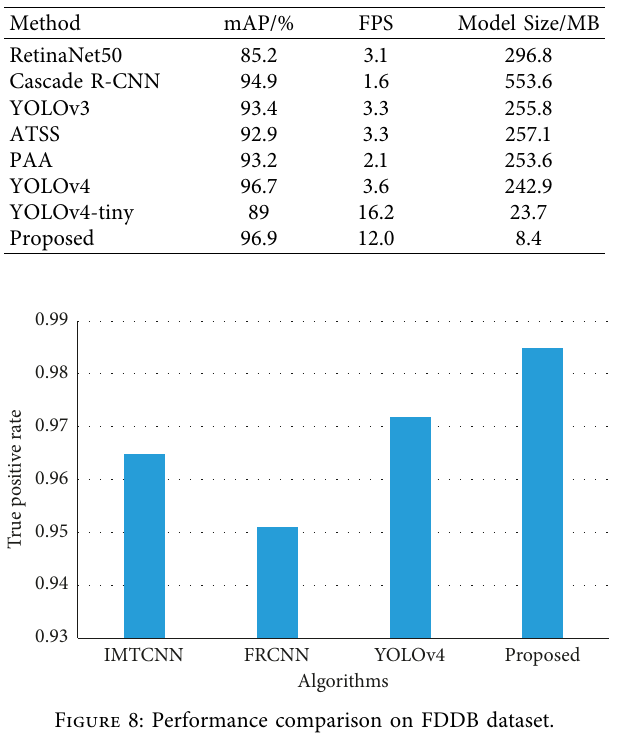
Table 5: Comprehensive comparison between this method and other mainstream